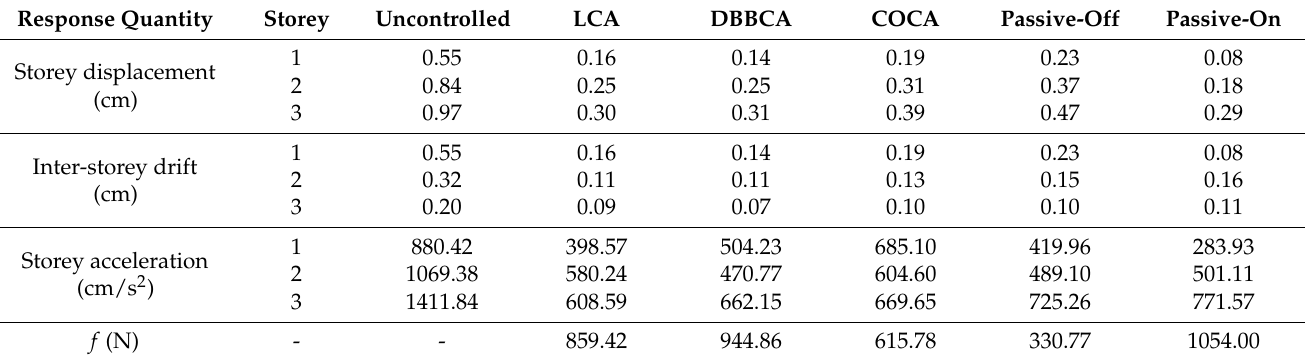
Table 1. Peak responses in a 3-storey structure [48] when subjected to a time-scaled 1940 Imperial Valley earthquake under different control